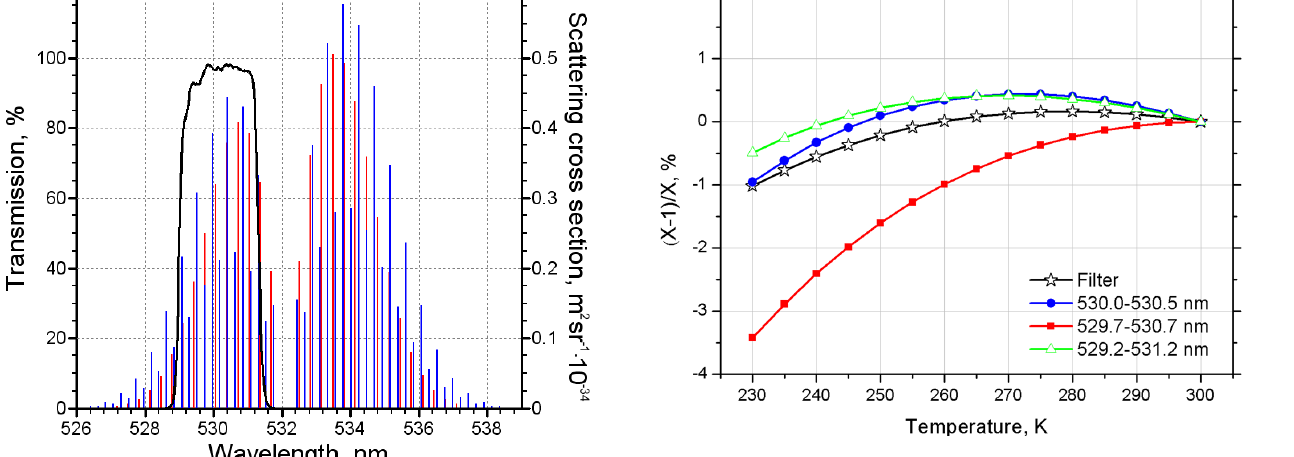
Figure 4. The relative change of RR scattering cross section (X − 1 )/X as a function of temperature for spectral range 530.0–530.5, 529.7–530.7, and 529.2–531.2nm. Open stars show results for the interference filter used in the experiment. The reference temperature used in computations is T 0 =